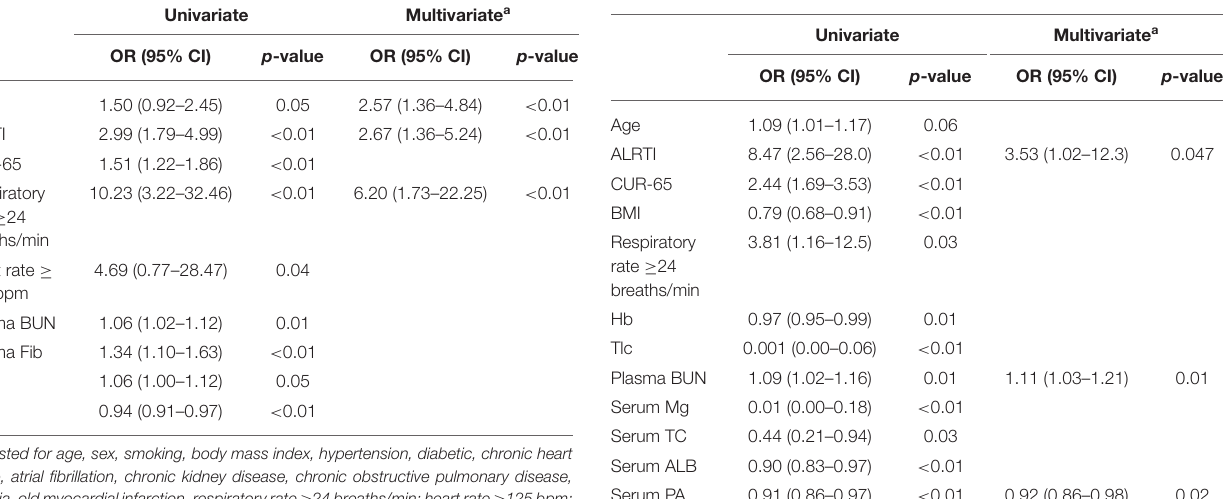
TABLE 5 | Risk factors associated with all-cause mortality in elderly patients with SCAD. Univariate Multivariate